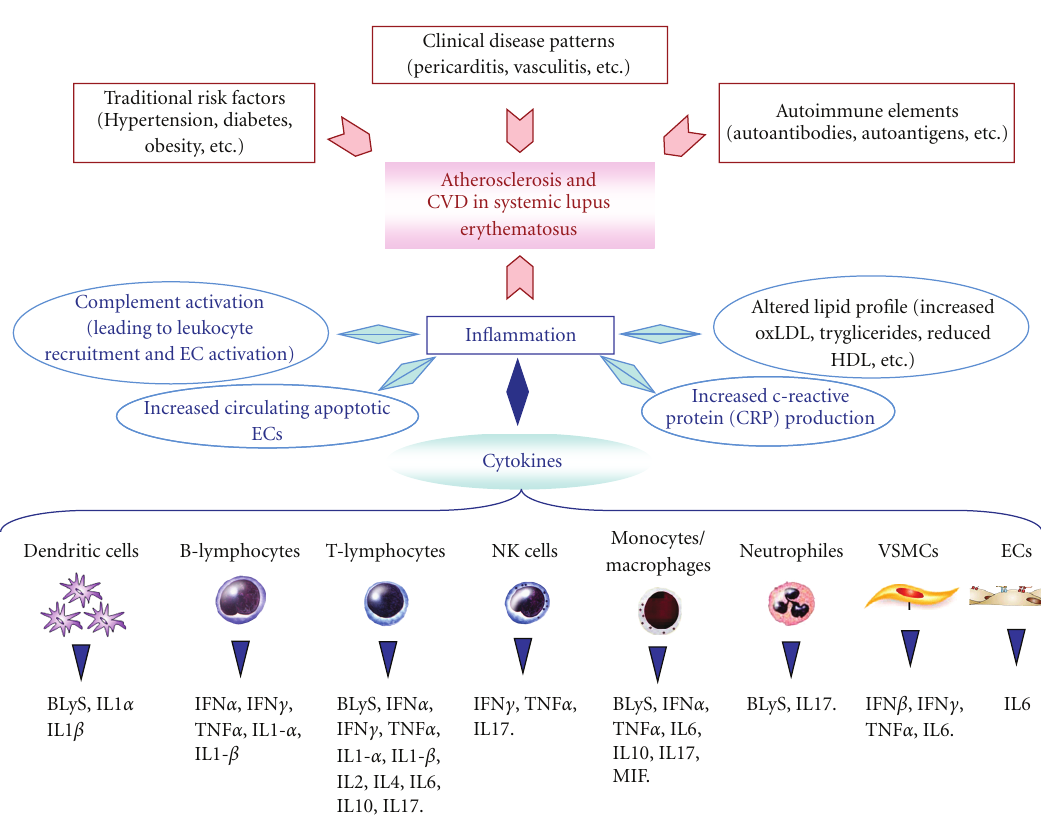
patients than in general population, they do not seem to fully explain that enhanced risk